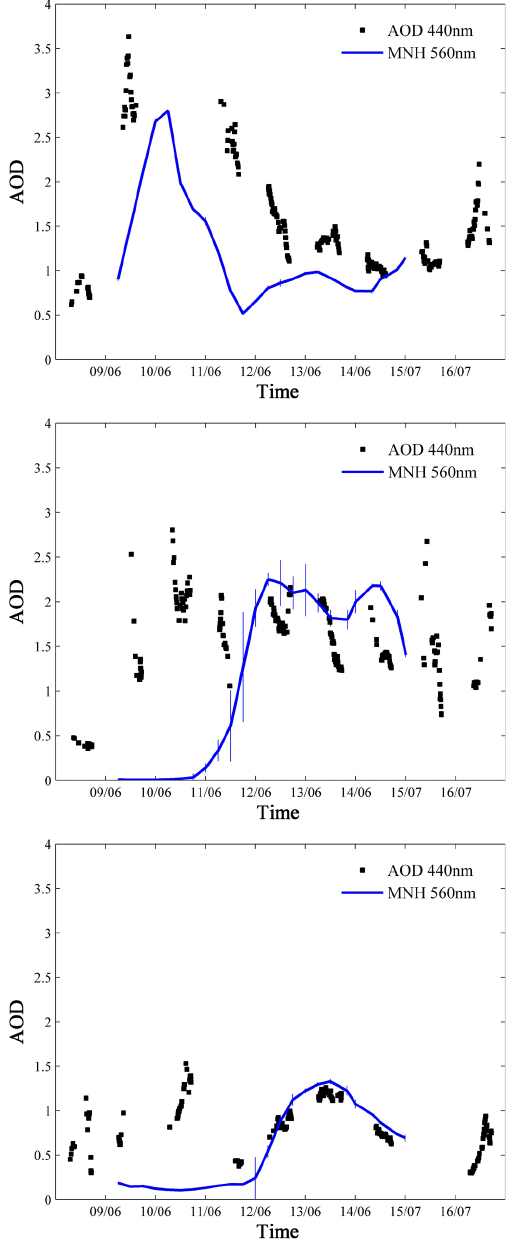
Fig. 4. Aerosol Optical Depth measured from 9 to 16 June 2006 over three Aeronet stations: Maine Soroa, Niger (a) , Banizoumbou, Niger (b) and Djougou, Benin (c)